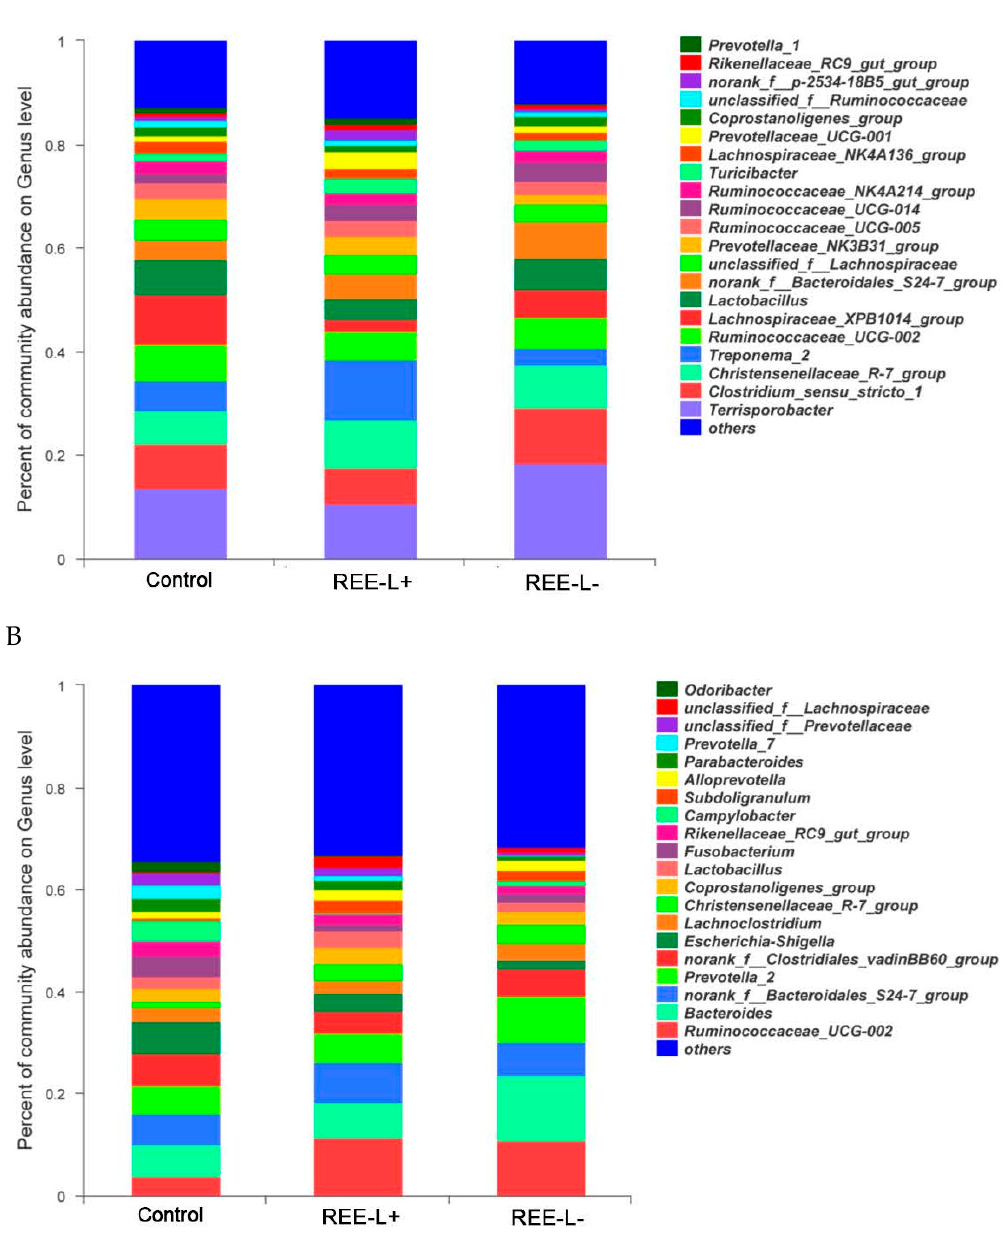
Figure 4. Abundant genera of fecal microbiota in ( A ) sows and ( B ) their piglets. n = 8 per group. REE-L+, REE supplied during gestation and lactation. REE-L-, REE supplied only in late gestation. Abundant genera of fecal microbiota in (Figure 4A) sows and (Figure 4B) their piglets. Significant differences in relative abundance of the fecal microbiota from phyla to genera were further identified using the LEfSe analysis. In lactating sows, proportions from the Spirochaetae phylum to Spirochaetaceae family were increased in REE-L+ group compared with the control group. Treponema_2 , Christensenellaceae_R-7_group , Prevotellaceae_UCG-001 , Ruminiclostridium_1 , Turicibacter , norank_f__Bacteroidales_BS11_gut_group genus was enriched in REE-L+ (Figure 5A), while Clostridia class from Firmicutes phylum and Lachnospiraceae_XPB1014_group genus showed